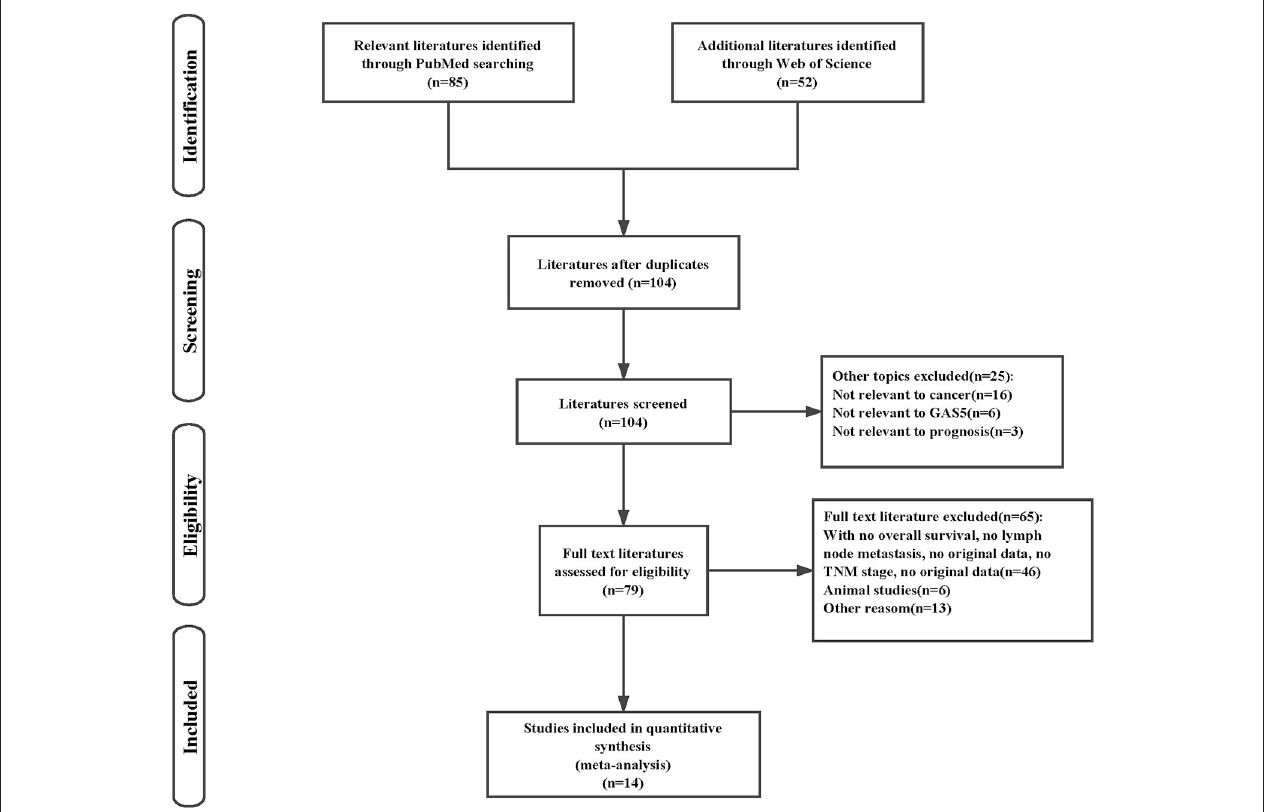
FIGURE 1 | Flow chart presenting the steps of literature search and selection.